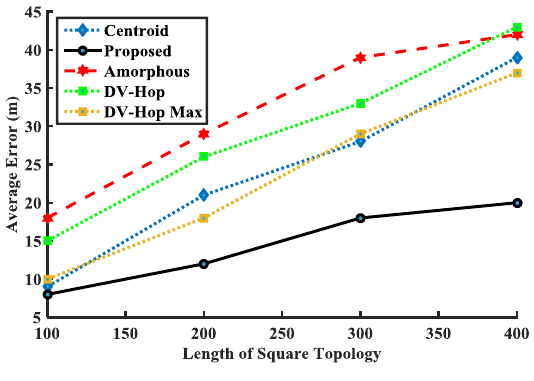
Fig. 5. Average localization Error vs Network size at 200 number of